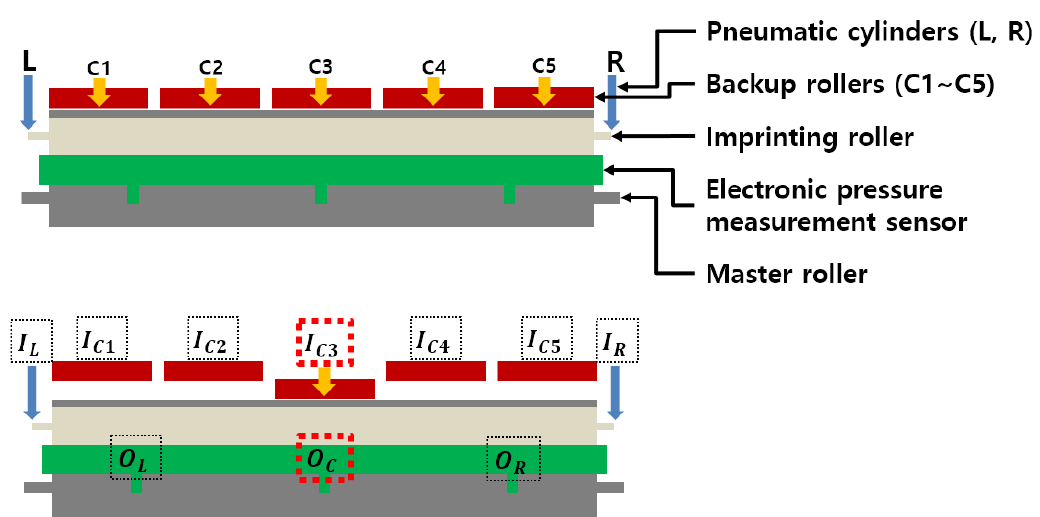
Figure 9. Schematic diagram of large-area R2R uniform pressing system for experiments; three output pressing forces ( 𝑂 𝐿 , 𝑂 𝐶 and 𝑂 𝑅 ) are selected to check the uniformity by the input pushing forces ( 𝐼 𝐿 , 𝐼 𝐶1 , 𝐼 𝐶2 ~ 𝐼 𝐶5 and 𝐼 𝑅 ). Firstly, 𝑂 𝐶 ’s change is investigated by engaging 𝐼 𝐶3 only.